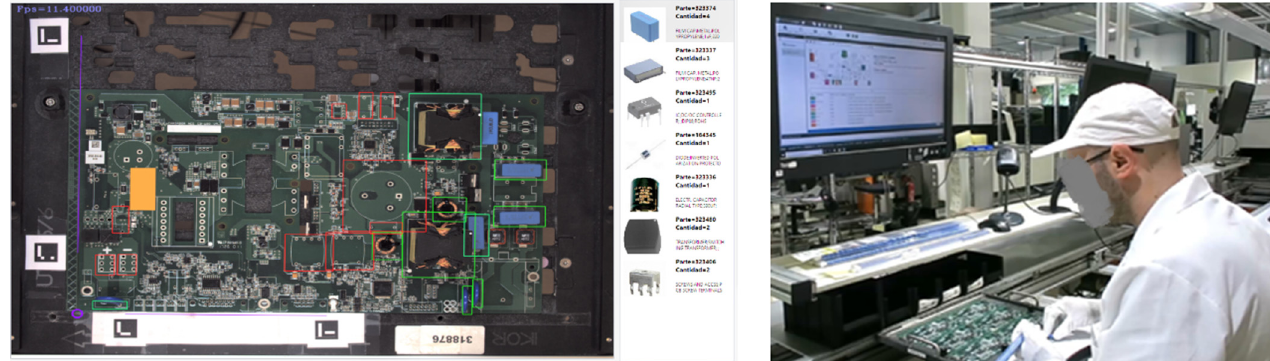
Fig. 3. Information presented to the operator via screen. Green rectangles denote mounted components, red rectangles denote missing component, and orange rectangle denote current mounting instruction [8].